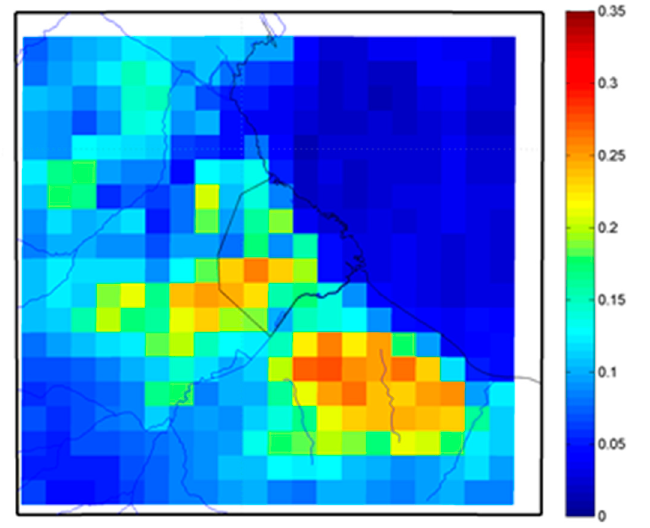
Figure 8. Aerosol optical depth annual average for 2014 from MODIS sensor (Aqua & Terra datasets combined) over Buenos Aires city and Gran Buenos Aires.